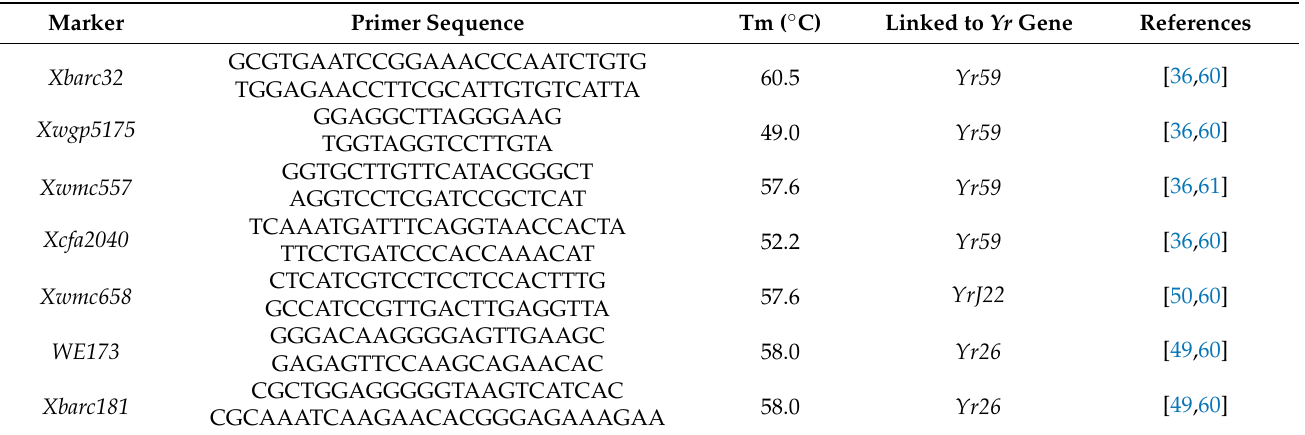
Table 1. Sequence and amplification information for simple sequence repeat (SSR) markers linked to Yr59 , Yr26 and YrJ22